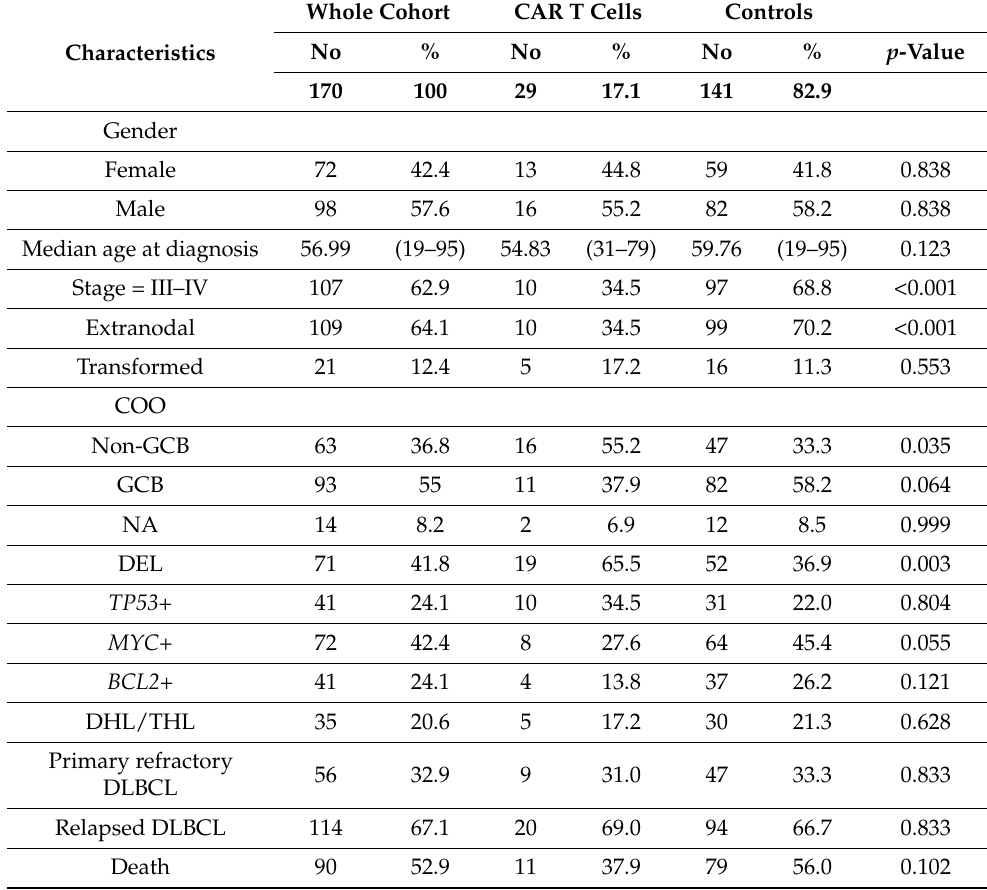
Table 1. Patient